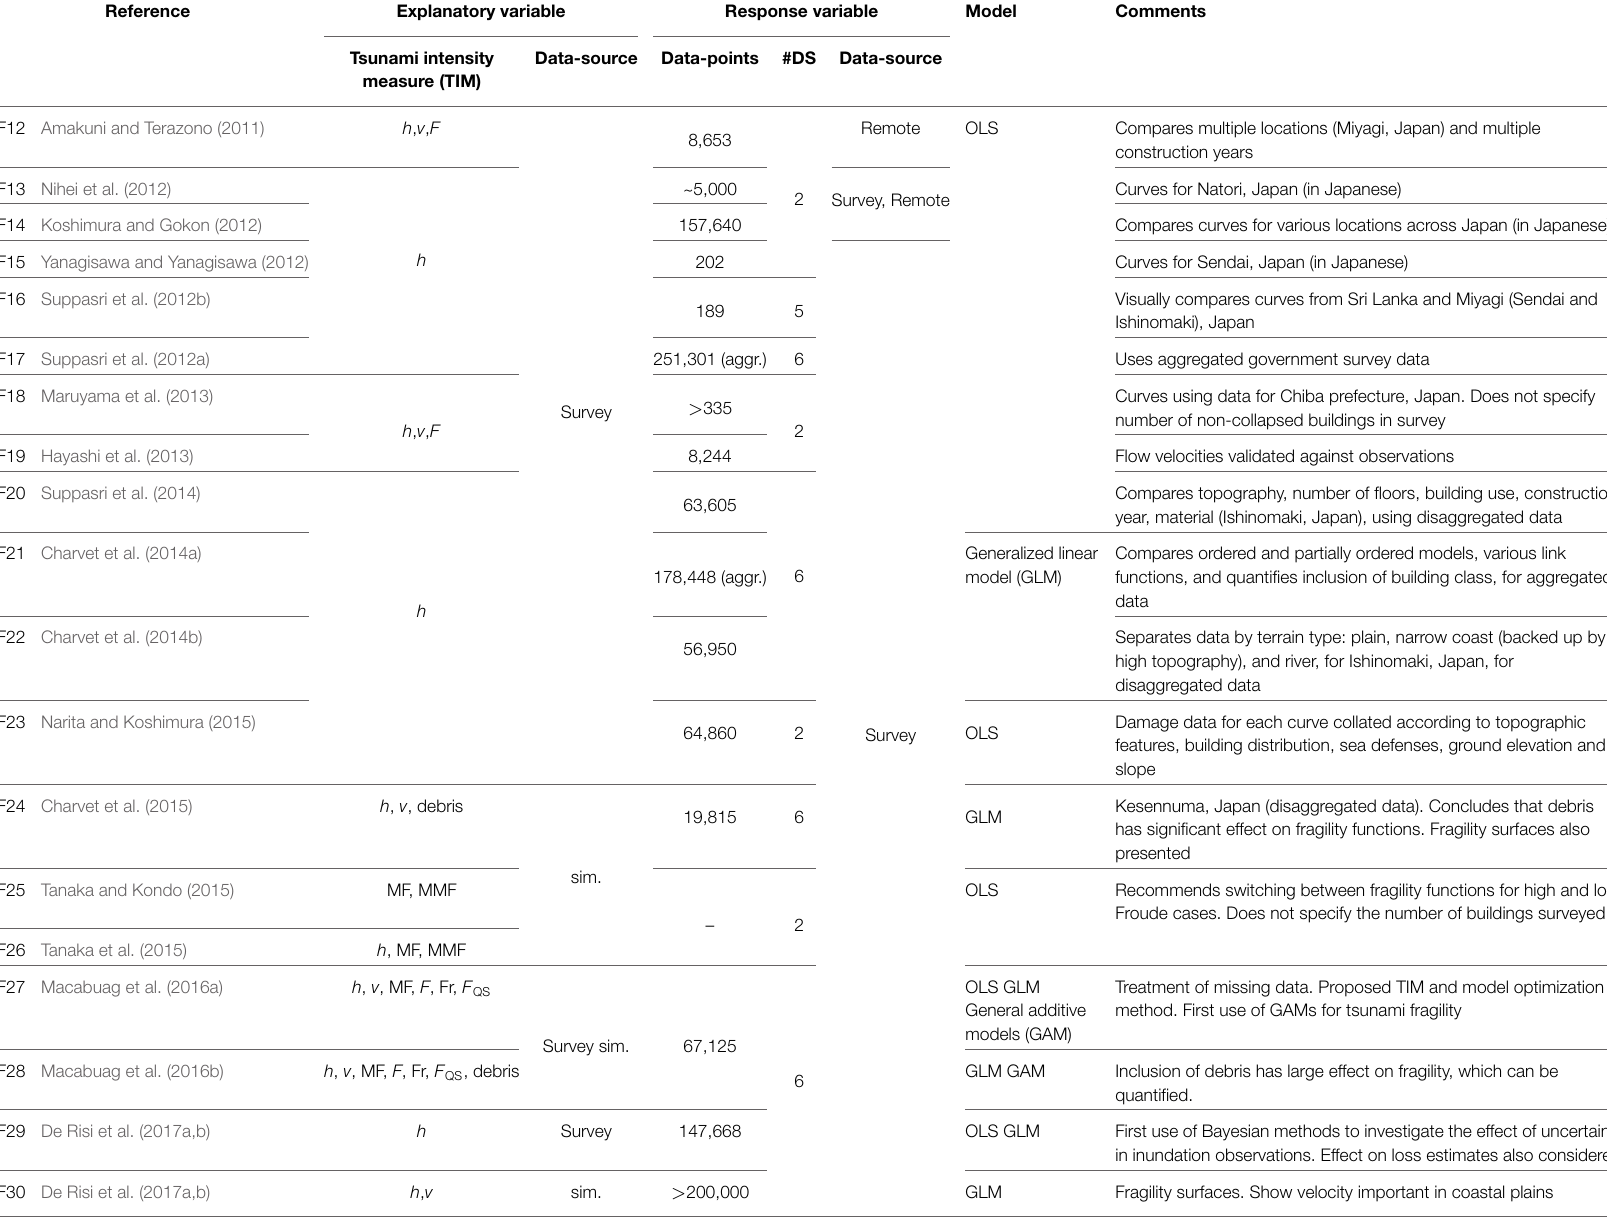
TABLE 2 | Published empirical fragility functions derived from data for the 2011 Great East Japan Earthquake and